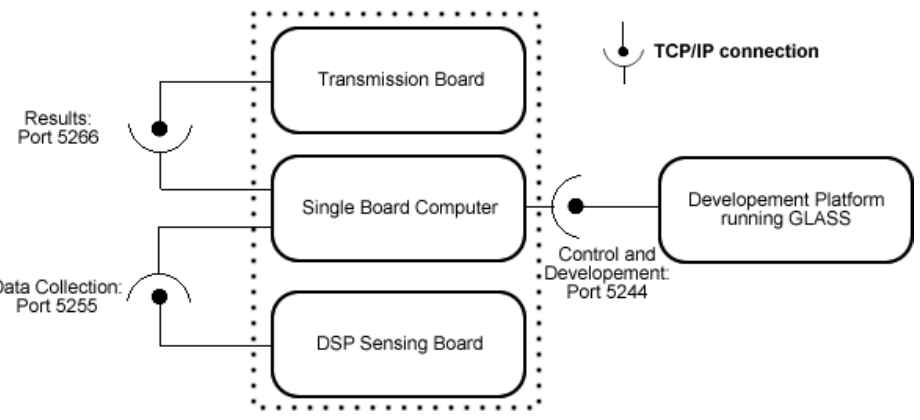
Fig. 3. An overview of the hardware configuration showing the modular approach and using Ethernet protocols for connecting